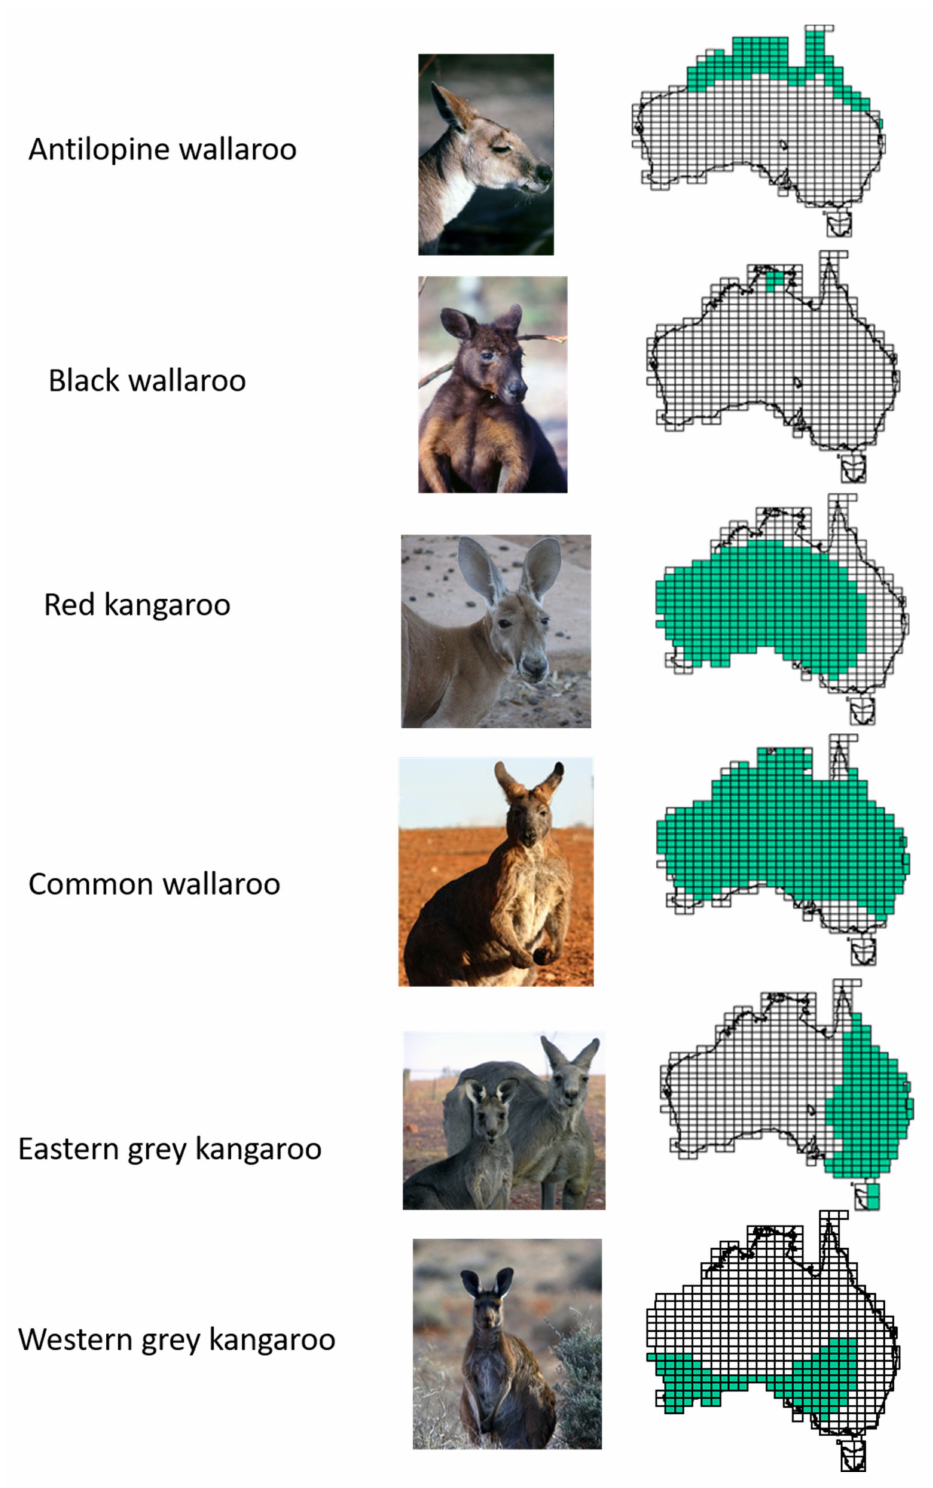
Figure 1. The six species of kangaroo and their distribution based on presence in 1:250,000 maps of Australia (see http://www.ga.gov.au; accessed on 21 April 2021). All images by